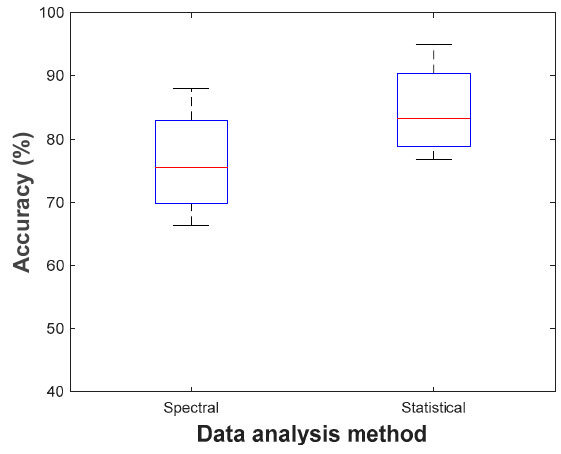
Figure 4. Classification accuracy with SCWT stressor.